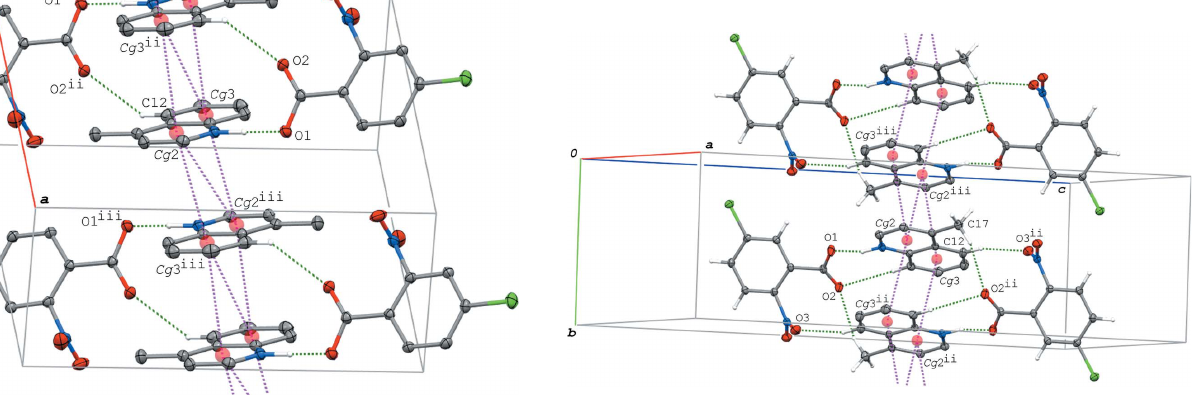
Figure 10 A packing diagram of (V), showing the ribbon structure formed via the (cid:2) – (cid:2) interactions (magenta dashed lines), and the N—H (cid:2)(cid:2)(cid:2) O and C— H (cid:2)(cid:2)(cid:2) O hydrogen bonds (green dashed lines). H atoms not involved in the hydrogen bonds are omitted for clarity. Cg 2 and Cg 3 are the centroids of the N2/C8–C11/C16 and C11–C16 rings, respectively. [Symmetry codes: (ii) (cid:3) x , (cid:3) y + 1, (cid:3) z + 1; (iii) (cid:3) x + 1, (cid:3) y + 1, (cid:3) z + 1.]